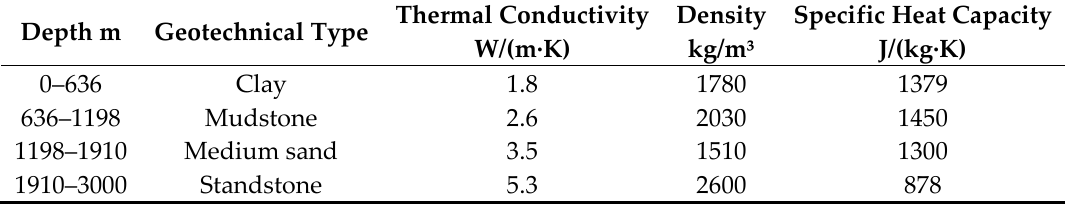
Table 3. The physical dimension and thermo-physical property of the soil and